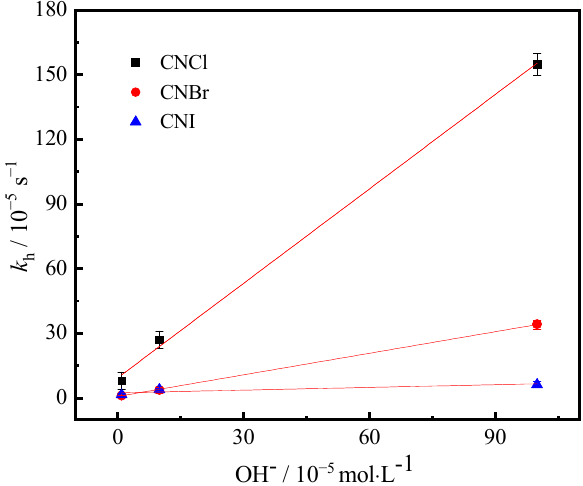
Figure 5. CNXs hydrolysis rate as a function of [OH − ].